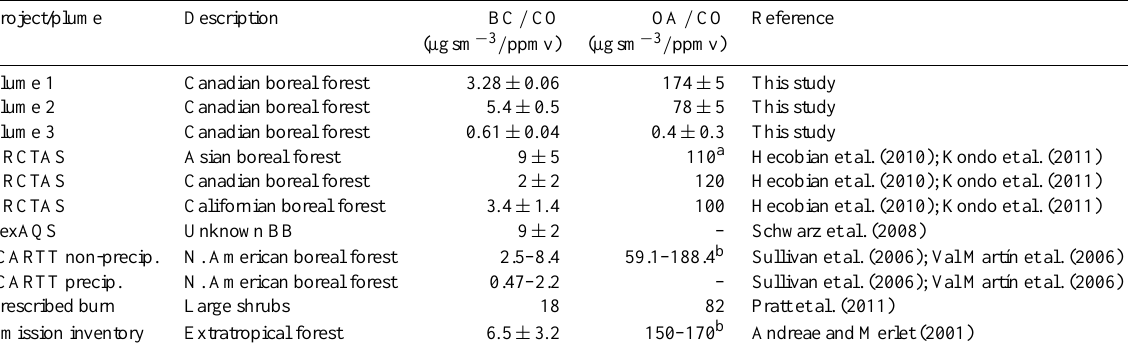
Table 1. Ratios of BC / CO and OA / CO from this study and several previous measurements. The ratios from this study were calculated from Fig. 3, and listed errors are the fit